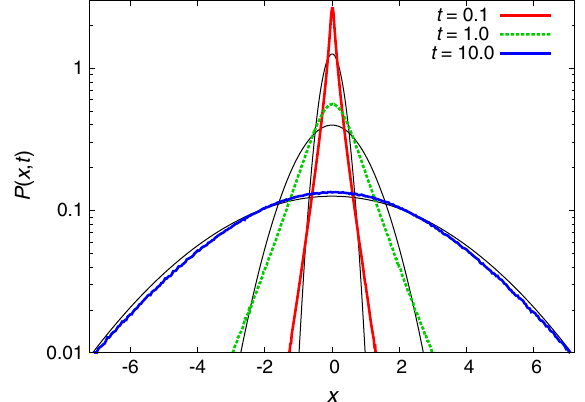
FIG. 5. Probability density function P ð x; t Þ for d ¼ n ¼ 1 from simulations of the Langevin equations (20) for three different times, in dimensionless form ( σ ¼ τ ¼ D ⋆ ¼ 1 ). Comparison with the Gaussian distribution (79) demonstrates the strongly non-Gaussian behavior at short times and the almost fully Gaussian shape at longer